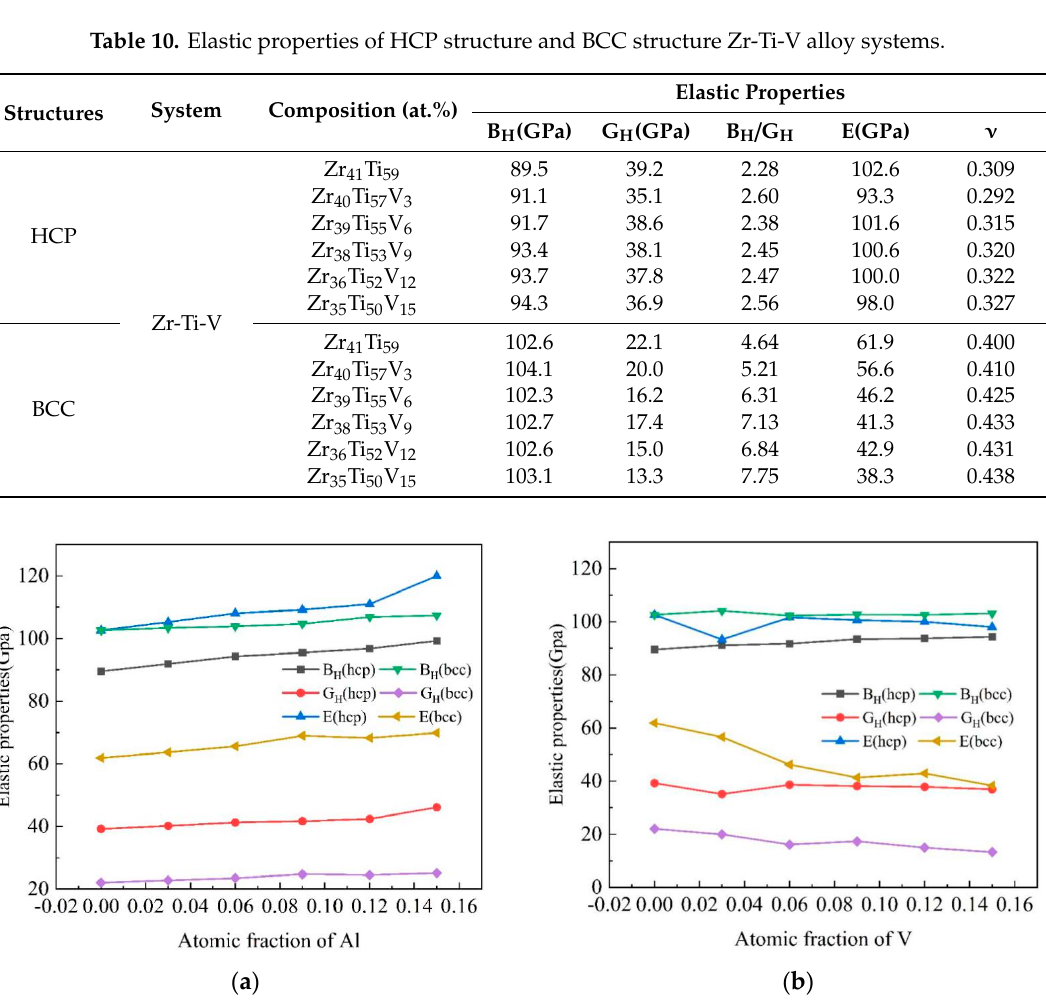
Figure 6. ( a ) Effect of Al atomic fraction on bulk modulus B H , shear modulus G H and Young’s modulus E of Zr-Ti-Al alloy system. ( b ) Effect of V atomic fraction on bulk modulus B H , shear modulus G H and Young’s modulus E of Zr-Ti-V alloy system.